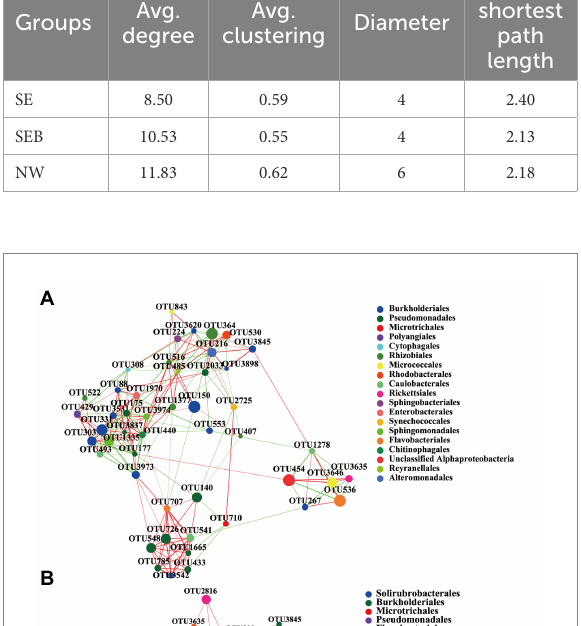
FIGURE 7 Differences in the community composition of B. calyciflorus - associated bacteria at different growth stages of each treatment groups. (A) SE Group. (B) SEB Group. (C) NW Group. Only the genera with significant differences in the top 15 relative abundance were shown. The Y axis represents the species name at a certain taxonomic level, the X axis represents the average relative abundance in different groups of species, and the columns with different colors represent different groups. Based on Kruskal-Wallis rank sum test p <